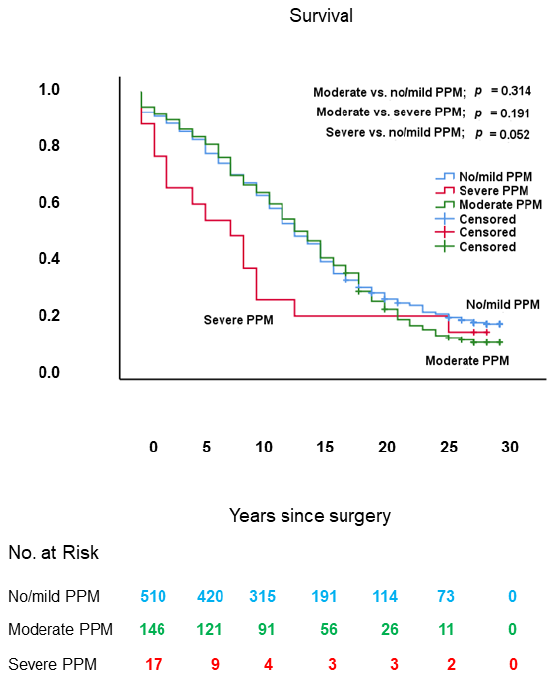
Figure 5. Kaplan–Meier survival curves, from date of surgery, of patients with moderate PPM, severe PPM, and no/mild PPM. PPM: prosthesis–patient mismatch.